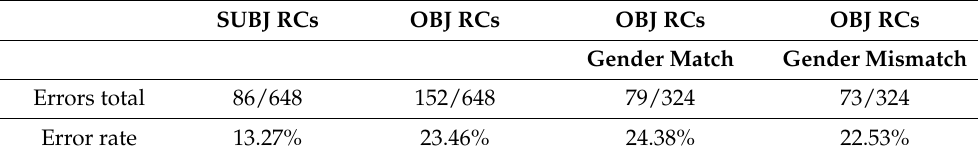
Table 2. Errors on Version 2 of the